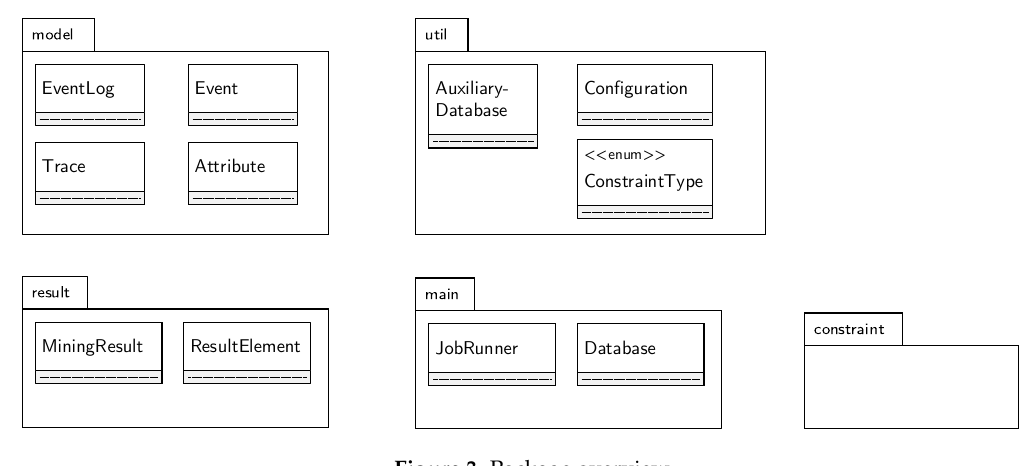
Figure 3. Package